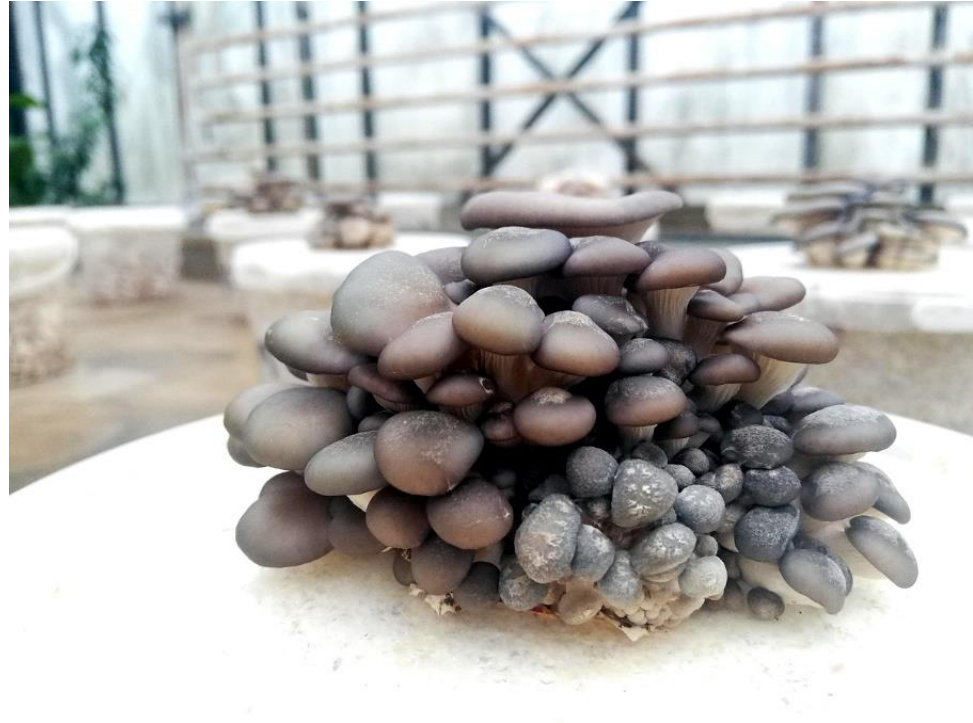
Figure 1. Fruiting body of Pleurotus ostreatus ( Source: Author of the work).